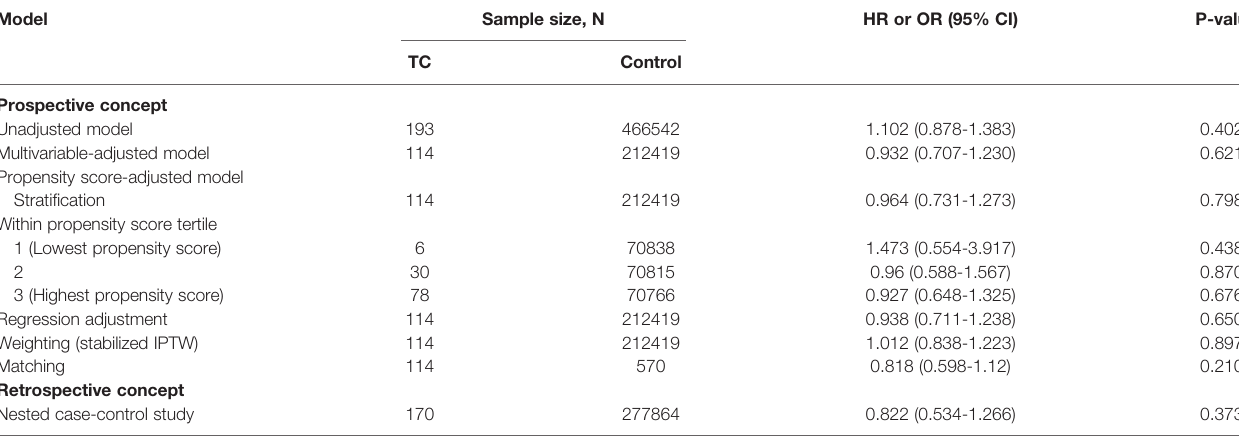
TABLE 4 | Risk of dyslipidemia compared between the patients with thyroid cancer and controls.